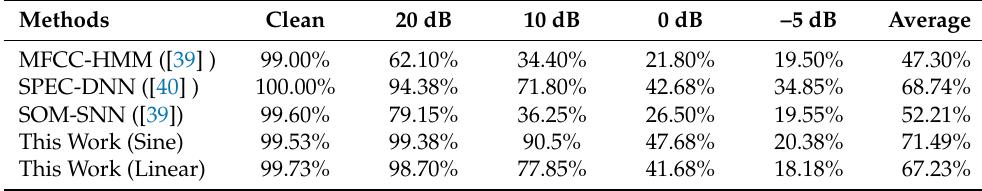
Table 4. Performance evaluation of various models in mismatched